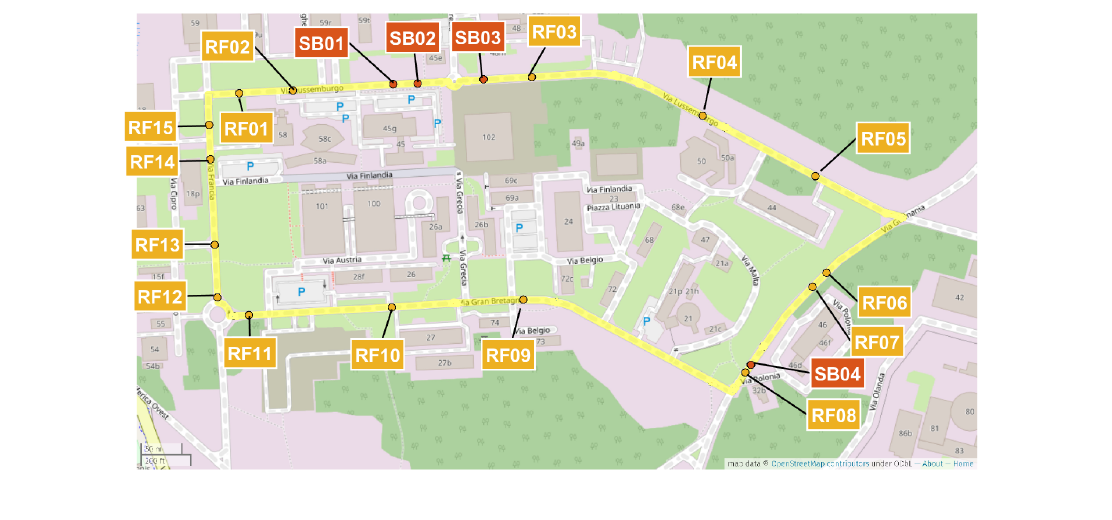
Figure 5. Map of the driving path/loop with the position of the road